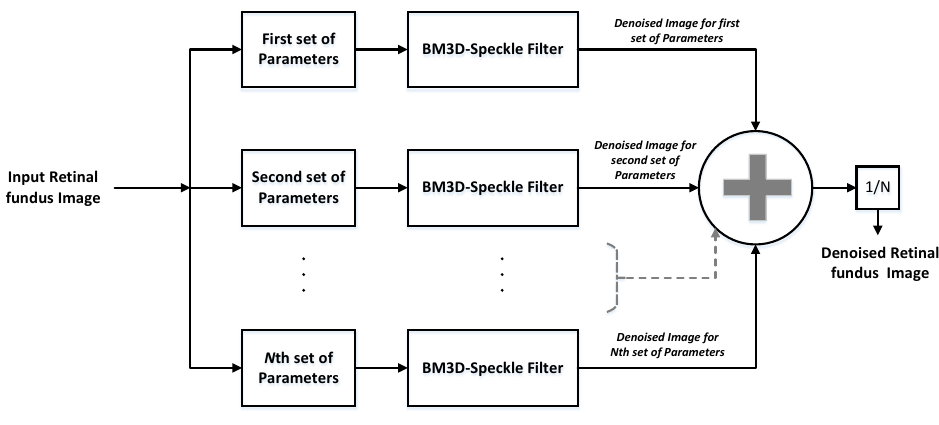
Figure 3. Block diagram of the proposed ensemble-block matching 3D (ES-BM3D) method that employs an ensemble of the speckle adapted (S)-BM3D filter to minimize